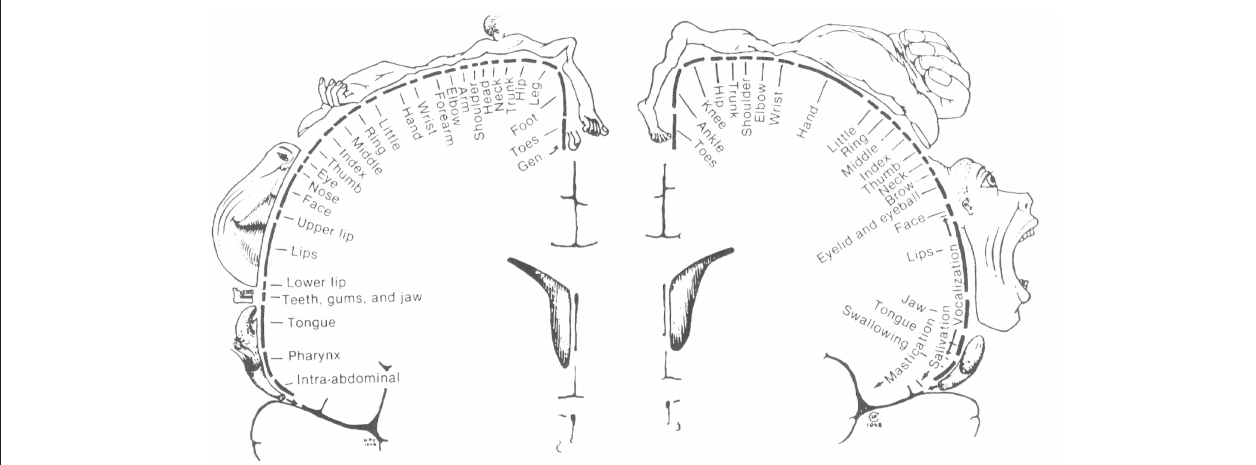
FIGURE 4 | The Penfield Homunculus: a visual representation of the mapping of body space in the somatosensory cortex of the brain, with the size of the body representing the size of the area of cortex devoted to it, and hence the sensitivity of that region as well. From Penfield and Rasmussen (1950). THE CEREBRAL CORTEX OF MAN. © 1950 Gale, a part of Cengage Learning, Inc. Reproduced by permission: